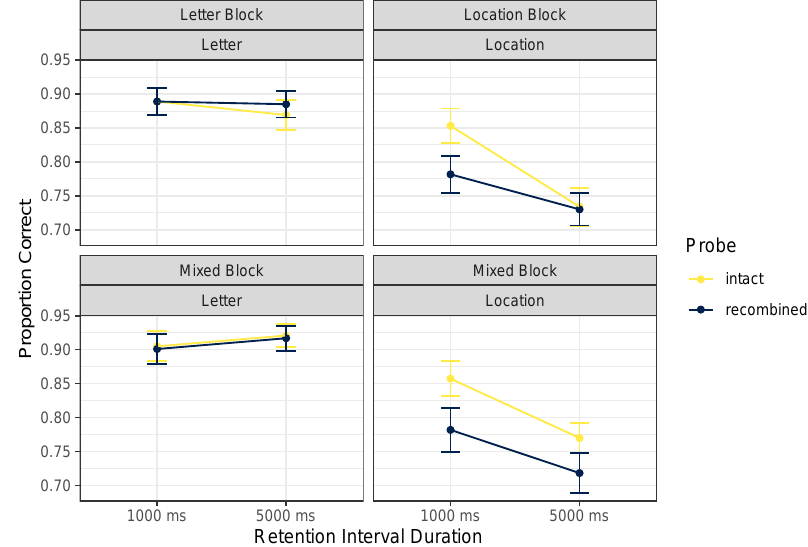
Figure 4. Mean proportions correct, Experiment 2. Error bars mark within-participant standard errors around the mean calculated with the Cousineau–Morey method [25].